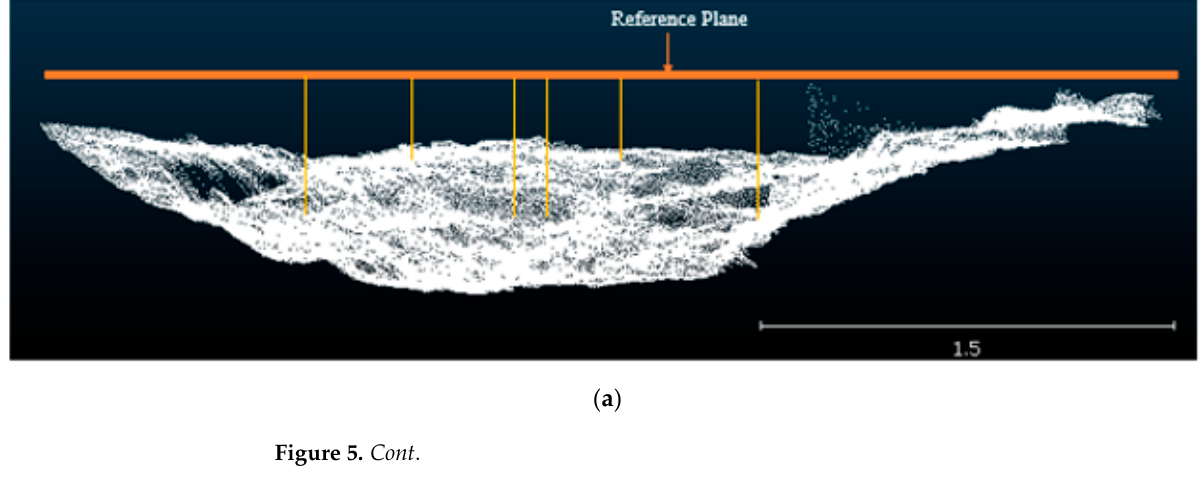
( c ) Figure 5. Scour scan using LiDAR: ( a ) LiDAR scan of scour point cloud (not a river cross-section)— 1.5 m; ( b ) image of scour hole (Pier 1); ( c ) scour hole point clouds looking from the direction of arrow in ( b ) (photo credit: S.E. Chen). 2. Three-Dimensional Finite Element Modelling To study the effect of scouring on important structural design parameters, a three- dimensional, non-linear finite element analysis of a single drilled pier foundation sup- porting the pier (Figure 4b) was developed using the FEA software Abaqus™ by Dassault systems ® (Abaqus Version 6.13 Documentation; Karlsson & Sorenson, Inc., Pawtucket, RI, USA, 2013) [33]. The bridge pier of the study site is supported on a 1.68 m diameter, 12.95 m long drilled shaft or drilled pile foundation. The pile protruded 15.0 cm above the ground level and was driven through four-layered heterogenous cohesive-frictional (c-ø soil), as shown in Figure 6. However, the soil is modeled 2.13 m below the tip of the pile in Abaqus™. As suggested by a few other studies including Chen et al. [34]; Karthigeyan et al. [35]; Strömblad [26]. The soil domain is extended to an extent of 10 times the pile (10D) diam- eter from the centerline to avoid the artificial boundary effect on pile-soil behavior. Thus, the overall dimension of the model assembly in Abaqus ™ is 34.34 m × 34.34 m × 12.95 m.